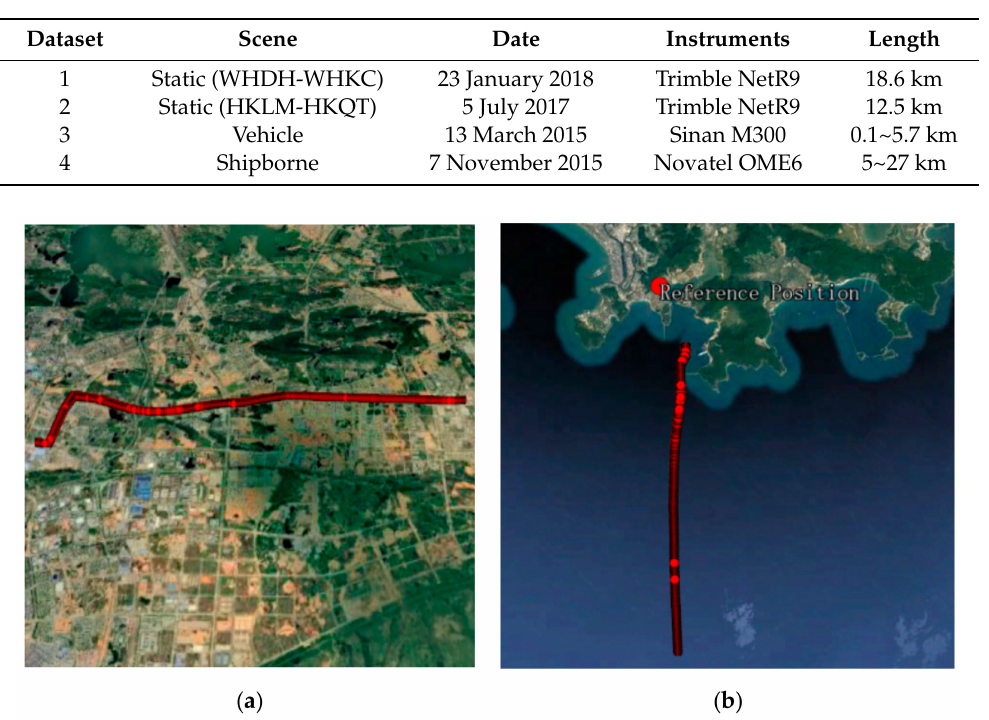
Table 2. Data information.